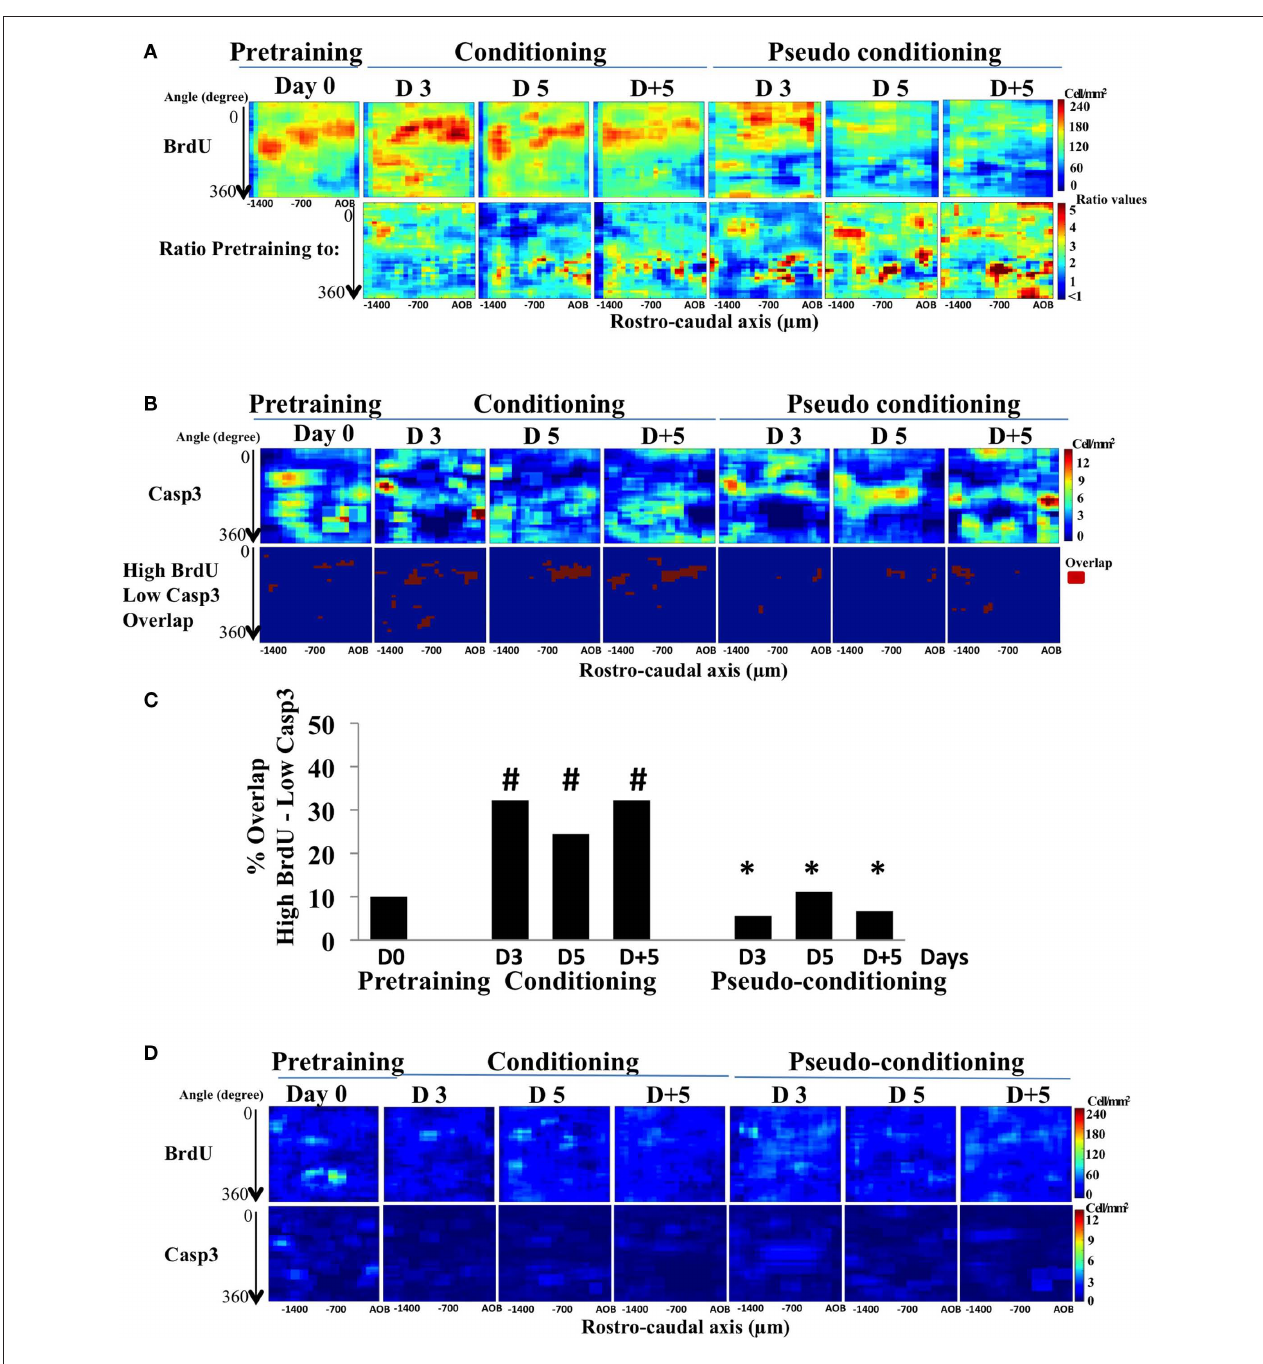
FigUre 4 | BrdU- and activated-caspase3-positive cell mapping in the gCL. (A) Pseudo-color maps of Brdu-positive cells (BrdU; upper panel) and of the ratio BrdU-positive cell-density map of pre-training to all other groups (lower panel). (B) Activated-caspase3-positive (casp3) cell-density maps and maps of the overlap between high BrdU and low caspase3 cell densities.